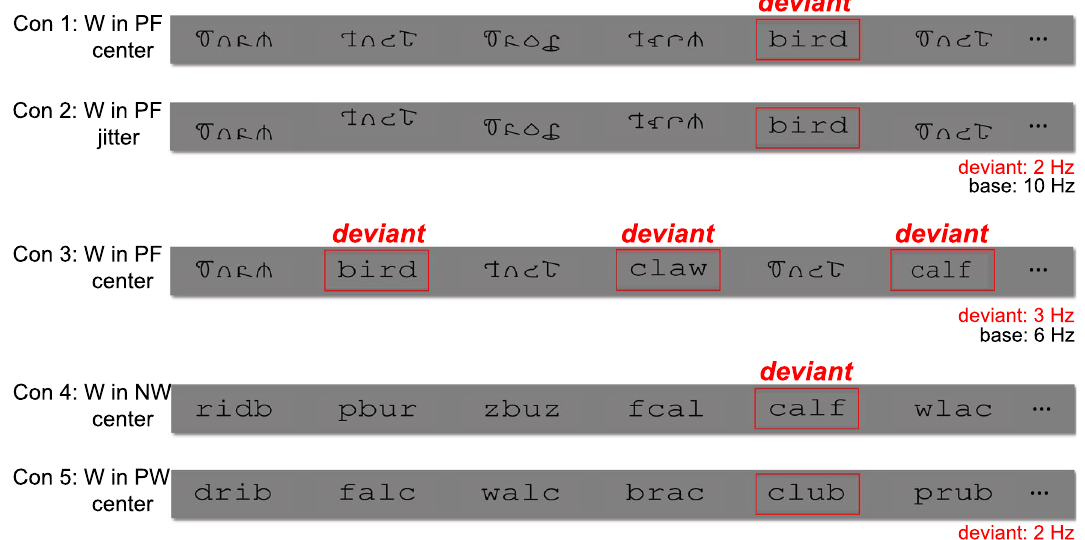
corrected for 4 comparisons) in condition 1 (word-in-pseudofont center); the first harmonic ( p FDR < 0.05 ) in